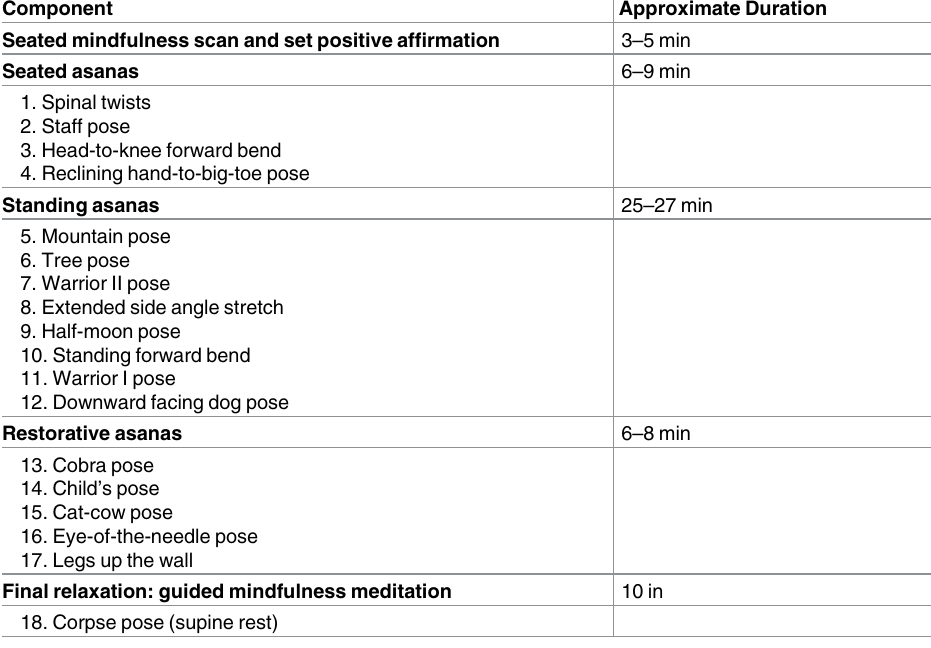
Table 1. Sample 60-minute yoga session